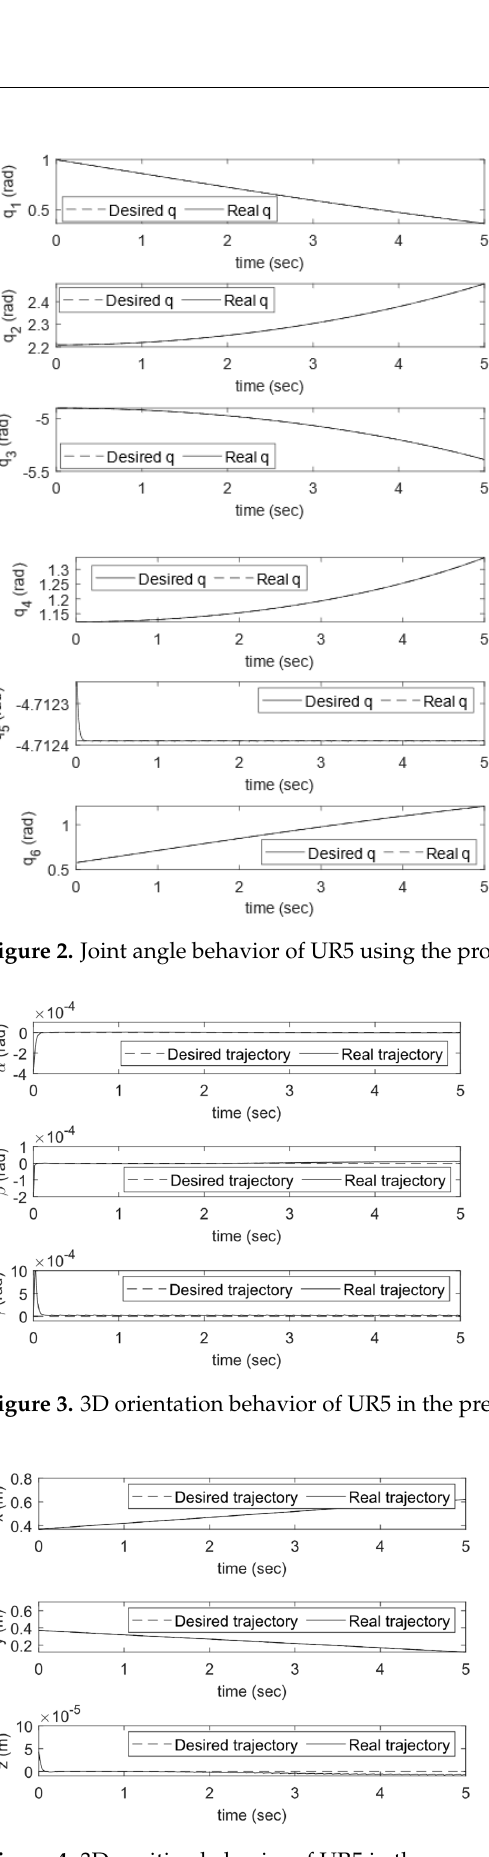
Figure 4. 3D position behavior of UR5 in the presence of the proposed controller.